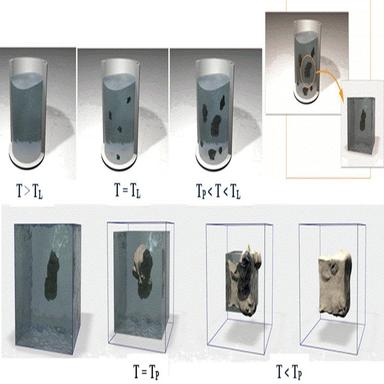
Theoretical synthesis process of a peritectic compound at ambient pressure during the solidification process under the equilibrium condition.